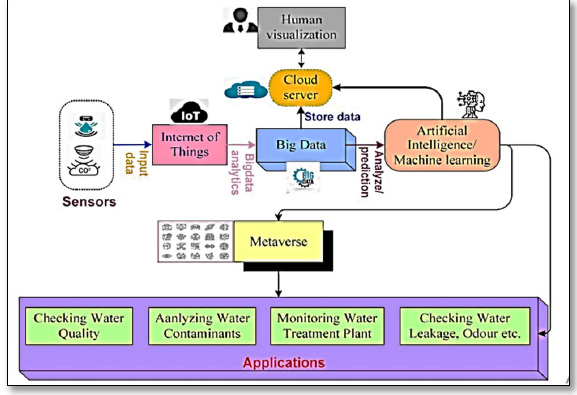
Fig. 5. The water management system. Source: Pandey et al.,